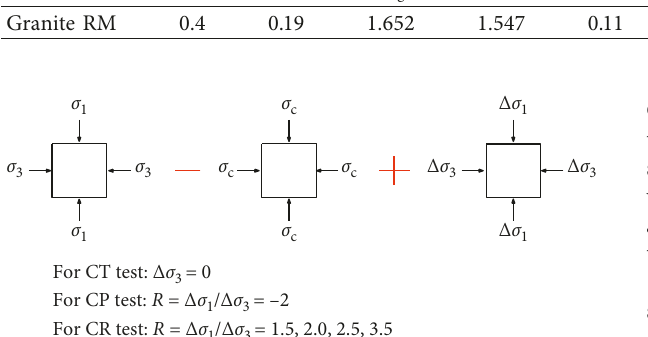
Figure 8: Illustration of three types of experiments involved in Yang et al.